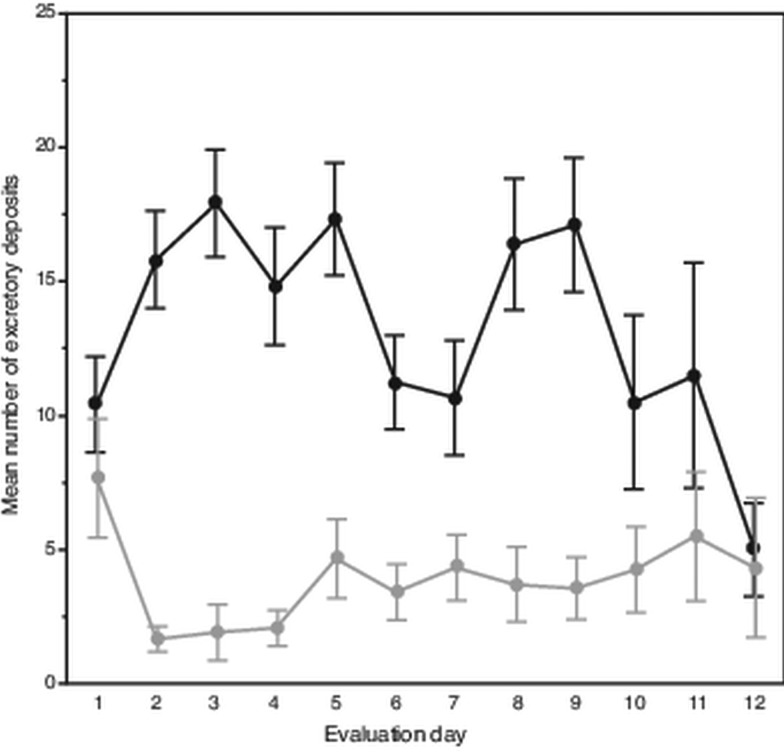
Daily number and location of female Varroa mite excretory deposits. Mean (± s.e.m) daily deposits of waste excretions made by mites observed over 12 days on integument of host honey bee pupae (upper dark line) and on inner wall of gelatin capsule (lower light line) housing mites and hosts.